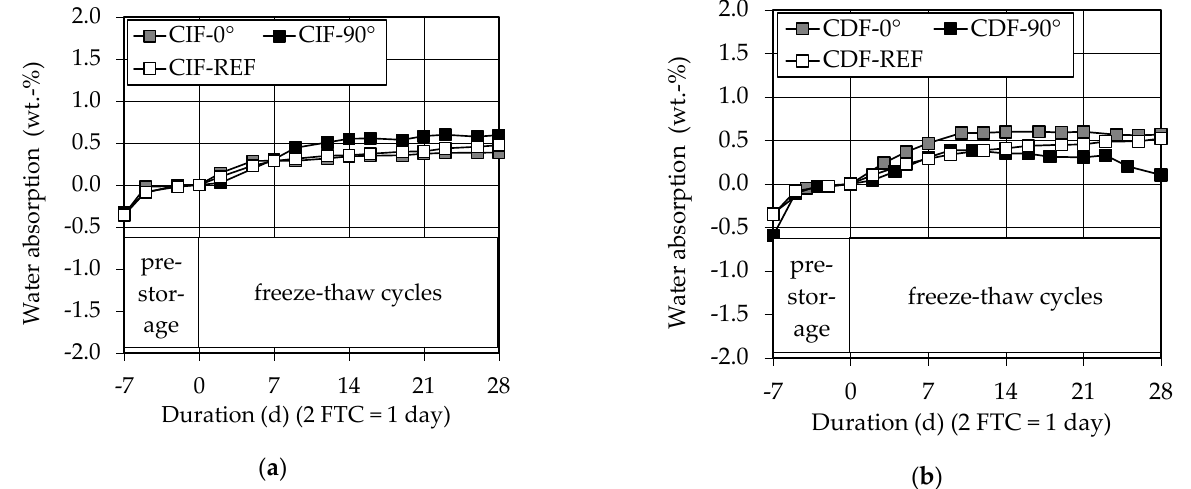
Figure 12. Water adsorption of ( a ) CIF specimens and ( b ) CDF specimens.